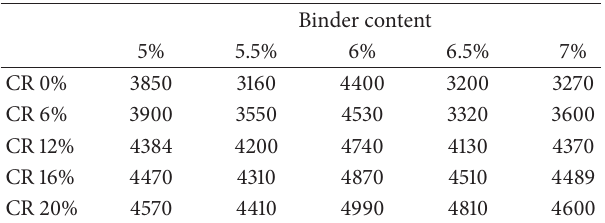
Figure 10: Resilient modulus versus CRM content. Table 9: Stiffness modulus results (Mpa) for different CRM con-